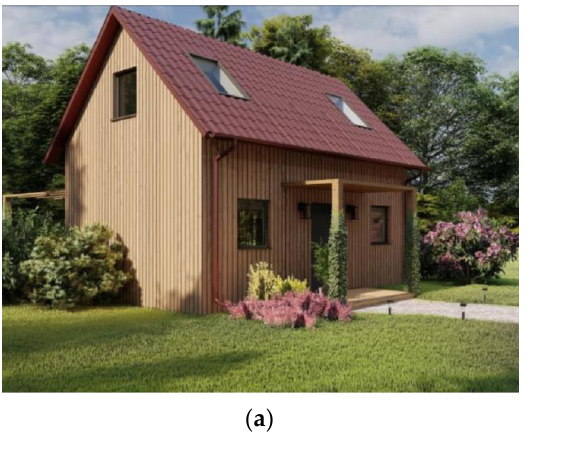
Figure 12. ( a ) Visualization of the selected building design; ( b ) Model made in ArCADia-Architektura software.